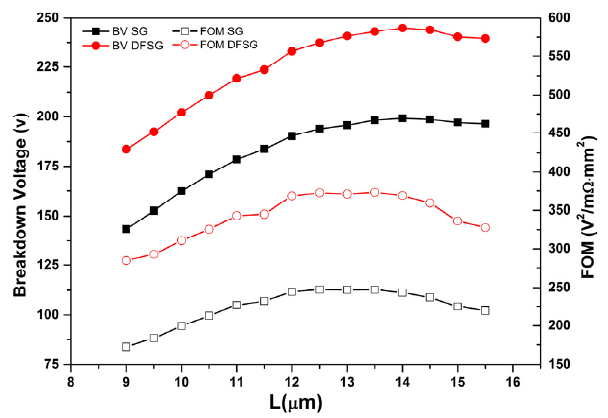
Figure 7. Dependence of the BV and FOM (BV 2 / R SP ) on the thickness of drift layer ( L ) for the SGRSO and DFSGRSO UMOSFETs.